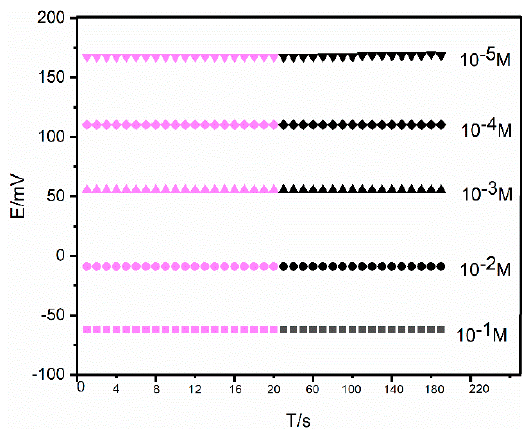
Figure 9. Response time of bromine ion selective electrode (Br-ISE) in different concentrations of KBr solutions.